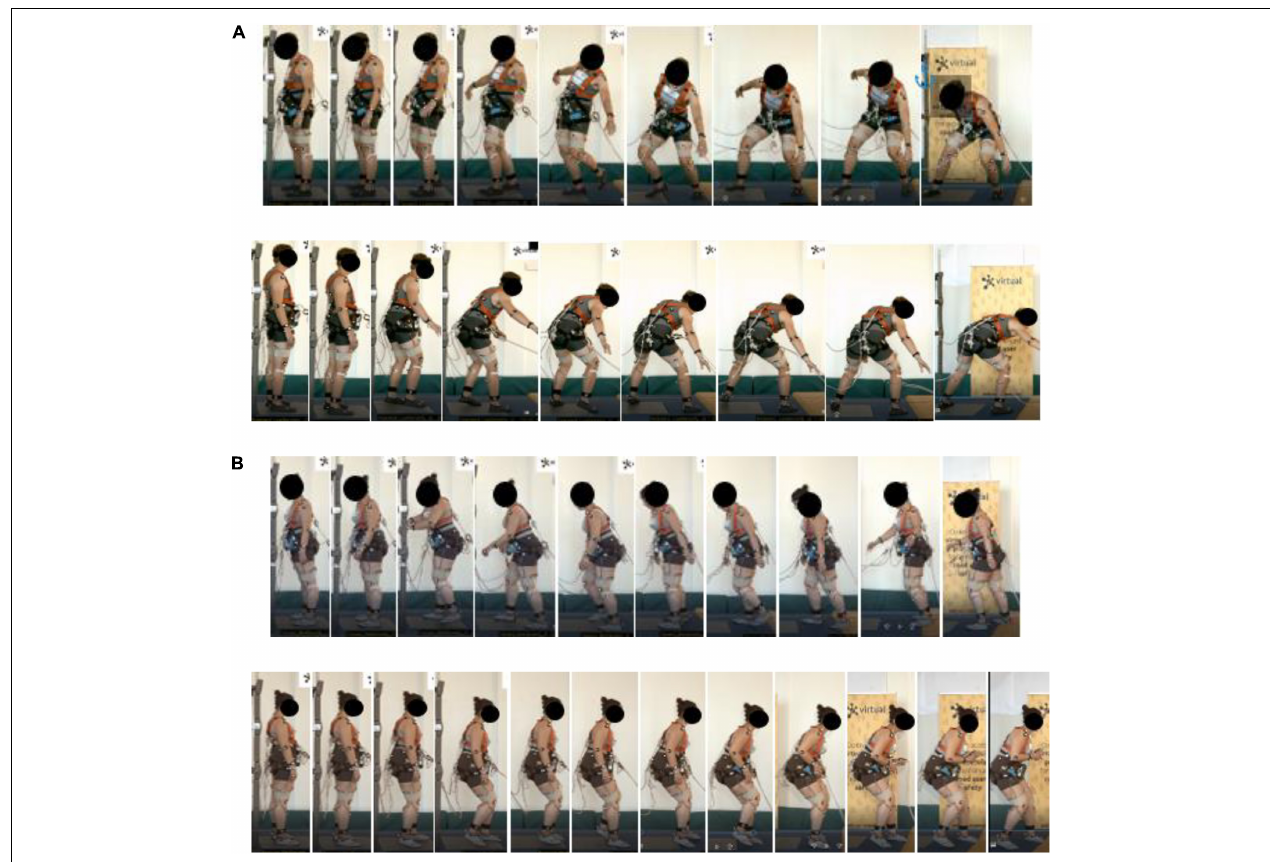
FIGURE 5 | Forward and rearward, (A) surfer (Volunteer 19) and (B) squat stance (Volunteer